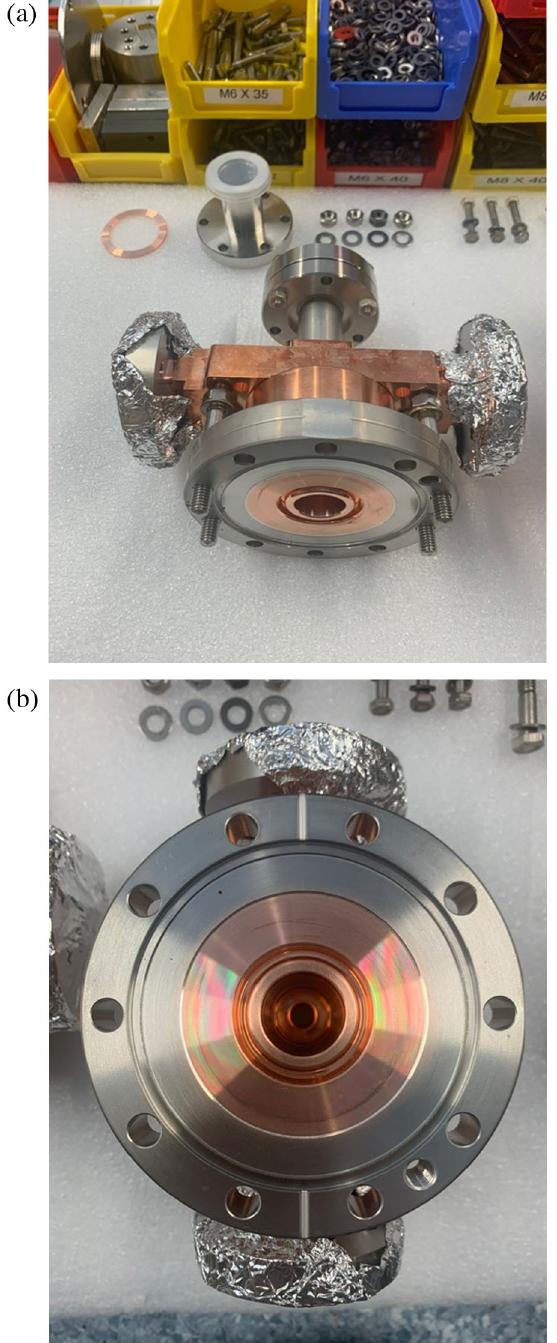
FIG. 15. (a) The coated dielectric tube is put into the outer copper jacket. (b) The assembly center-part prototype with the vacuum and transmission coefficient S 0 21 ¼ ð S 21 þ S 23 þ S 41 þ S 43 Þ = 2 for a full-assembly structure with four ports (ports 1, 2, 3, and 4), where S ( i; j ¼ 1 ; 2 ; 3 ; 4 ) are S parameters ij for this four-port structure. However, this asymmetry can be mitigated by introducing symmetrical power splitters into